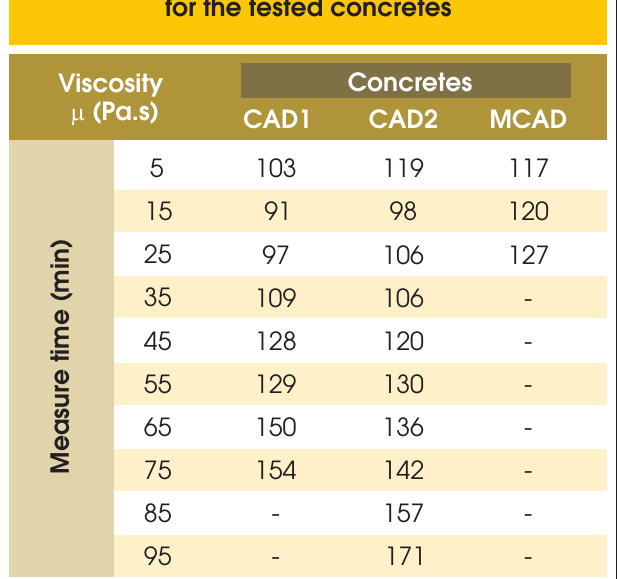
Table 20 – Results of the viscosity over time